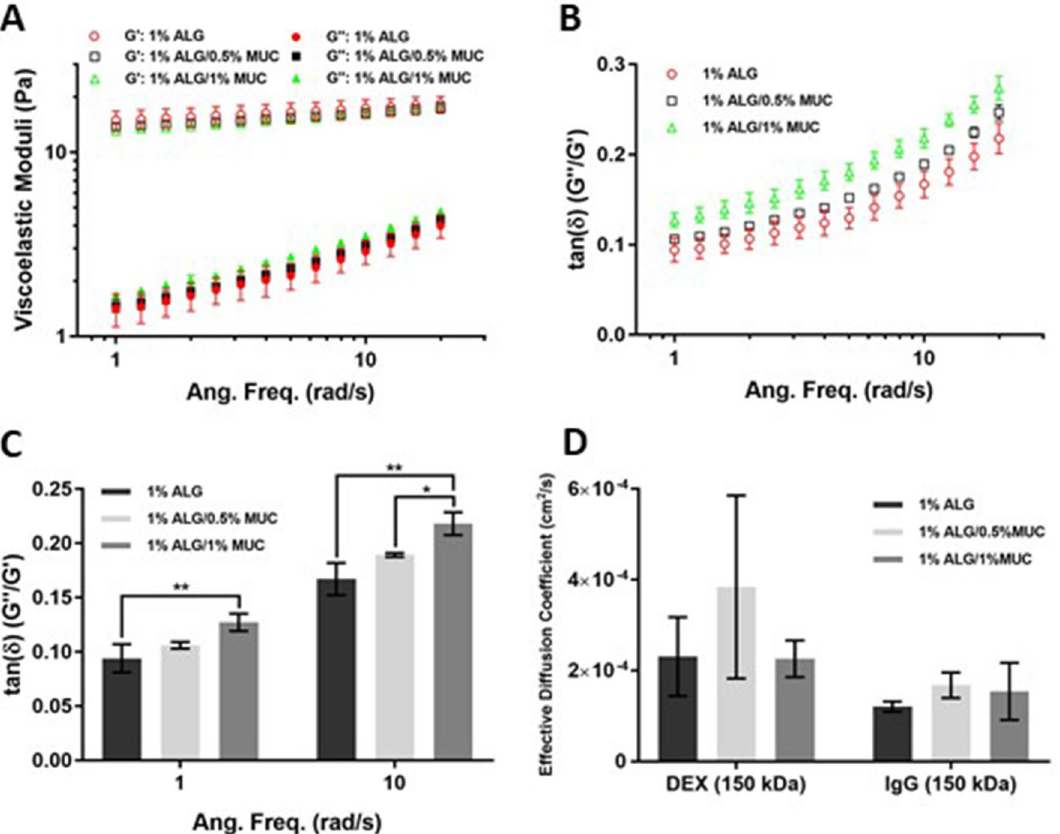
Figure 7. Rheological measurements and effective diffusivity of alginate-based hydrogels (1% ALG, 1% ALG/0.5% MUC, and 1% ALG/1% MUC). ( A ) Viscoelastic moduli of alginate-based hydrogels measured at angular frequencies from 1 to 19.95 rad/s, where G ′ is the storage (elastic) modulus and G ″ is the loss (viscous) modulus. Loss tangent of alginate-based hydrogels at a range of angular frequencies (1–19.95 rad/s) ( B ) and a comparison of tan(δ) at low (1 rad/s) and high (10 rad/s) angular frequencies, where *indicates p < 0.05 and **indicates p < 0.01 (n = 3). ( D ) Effective diffusion coefficients (D eff ) of dextran (DEX) and immunoglobulin G (IgG) within alginate-based hydrogels (n =